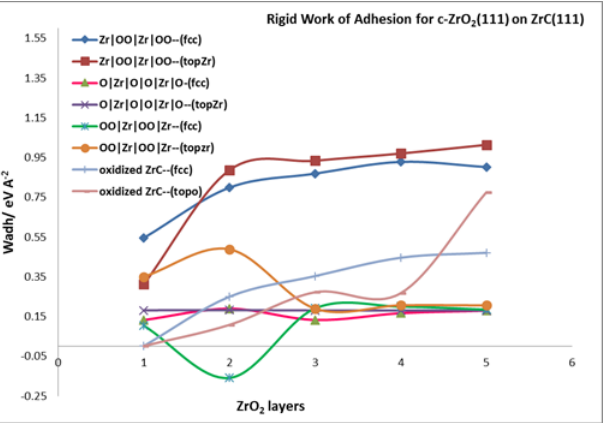
Figure 5 . Rigid Work of adhesion for different interface models of c -ZrO 2 (111) on ZrC(111)